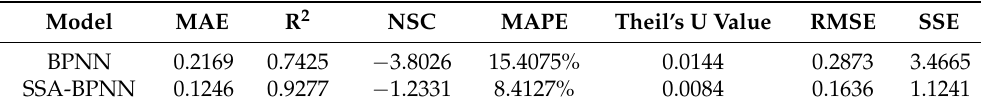
Table 3. Evaluation index values of BPNN and SSA-BPNN